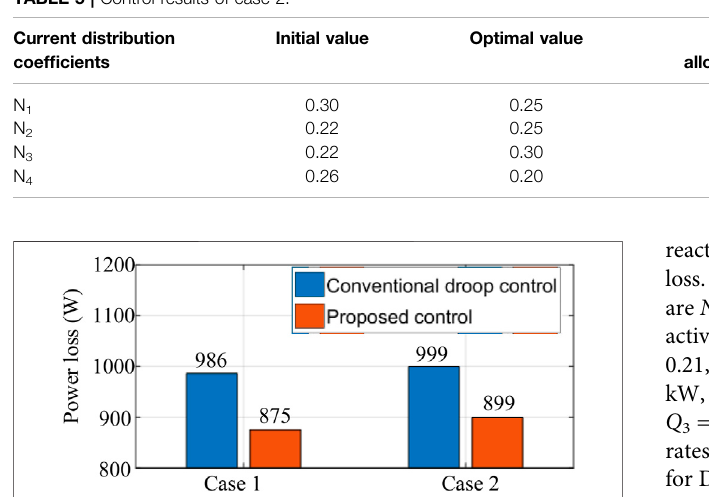
TABLE 5 | Control results of case 2.